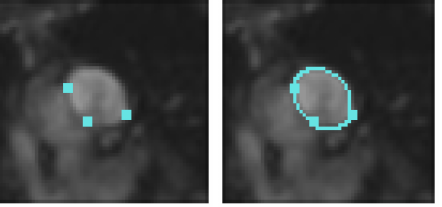
Figure 7. Left : interpolation conditions. Right : final result after 8 iterations using our proposed